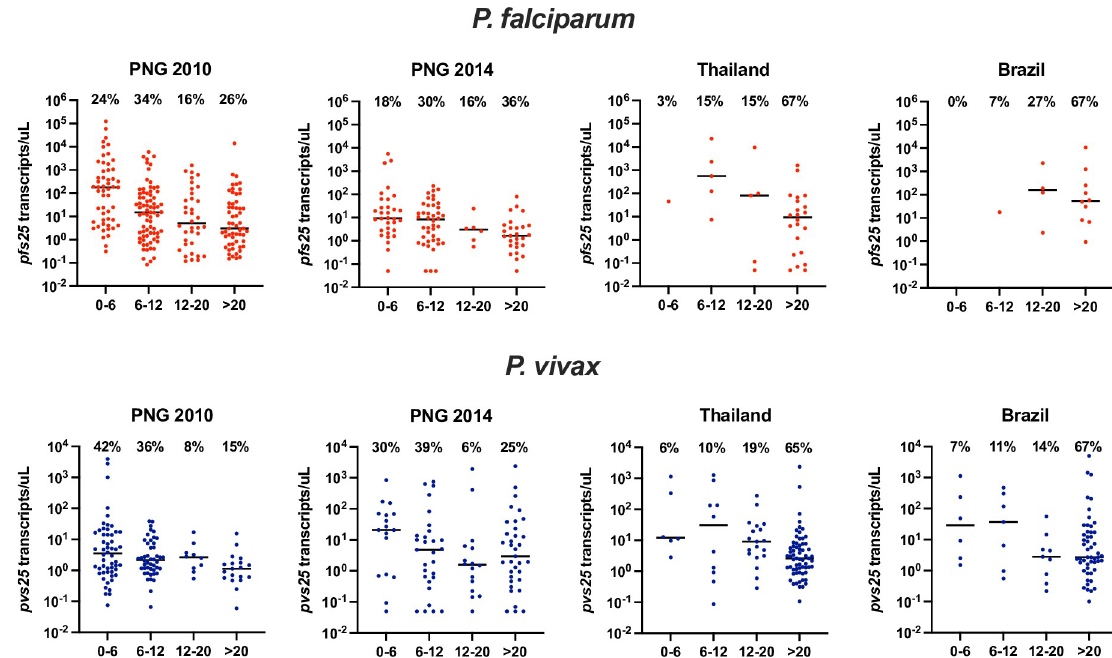
Fig 4. pfs25 and pvs25 transcript densities for each survey stratified by age group. The black line shows the median. The percentage shows the proportion of gametocyte carriers in an age group among all gametocyte carriers within this